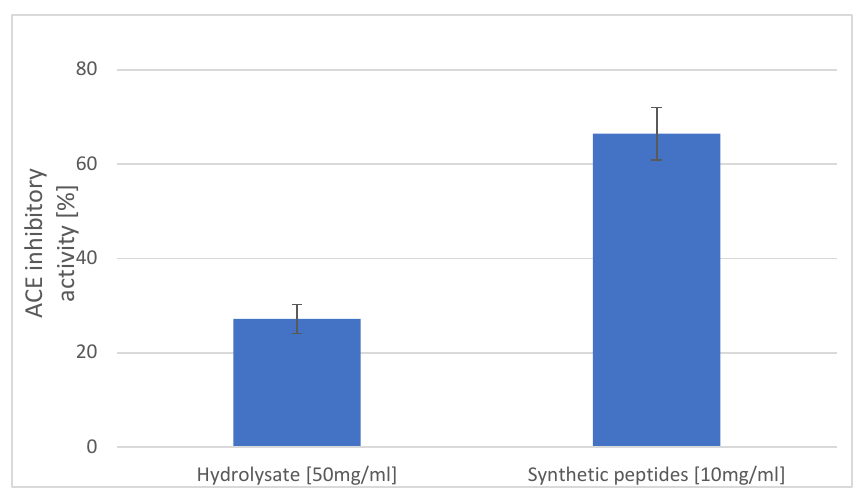
Figure 4. ACE-inhibitory activity [%] of hydrolysates and the synthetic Ala-Tyr peptide.